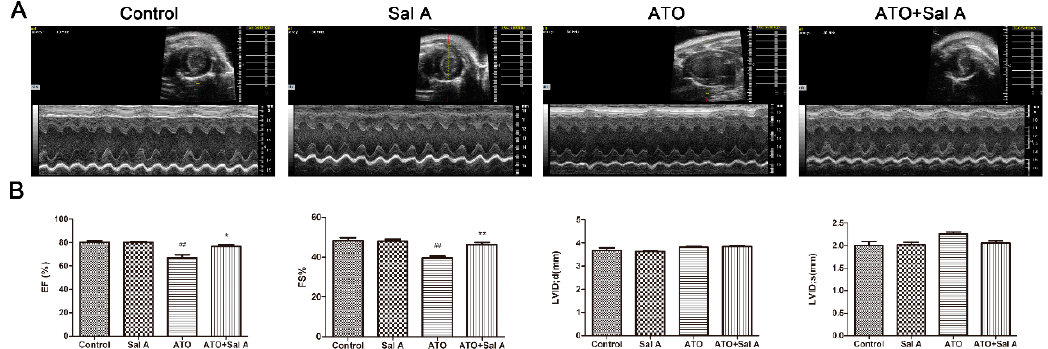
Figure 2. Sal A ameliorated left ventricular functions after ATO treatment. After mice were treated with saline or ATO with/without Sal A pretreatment for two weeks, echocardiography was finished. ( A ) Images of M-mode echocardiograms; ( B ) echocardiography indices, expressed as the mean ± SD. EF, ejection fraction; FS, fractional shortening; LVIDd, left ventricular internal diameter in diastole; LVIDs, left ventricular internal diameter in systole. ## p < 0.01 vs. control; * p < 0.05 vs. ATO group; ** p < 0.01 vs. ATO group.